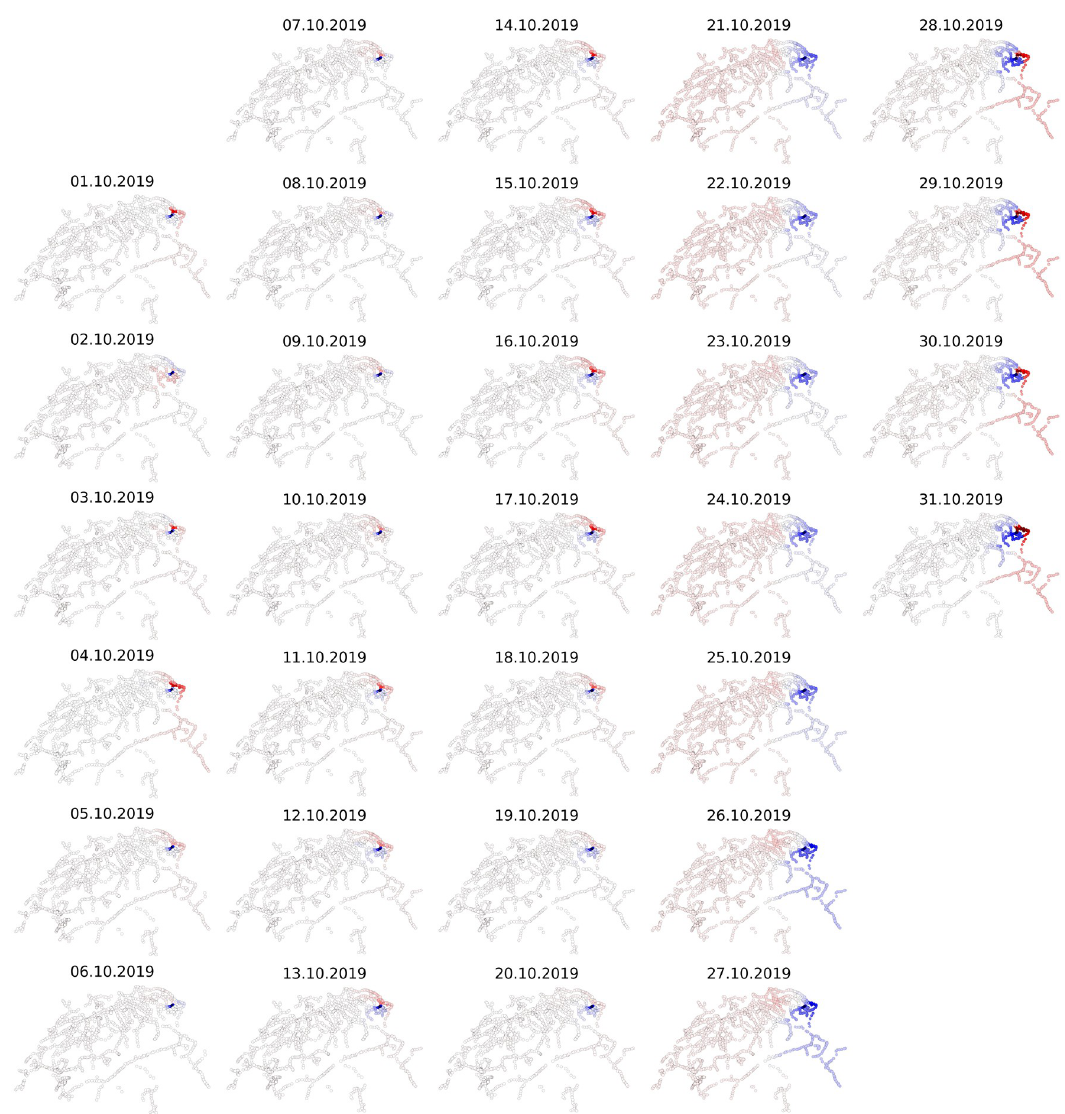
Fig 5. Countrywide effect on π by a disruption at St. Gallen. Percentages of change with respect to the corresponding stationary distribution. Positive changes (red) suggest increased traffic, negative changes (blue) reduced traffic.